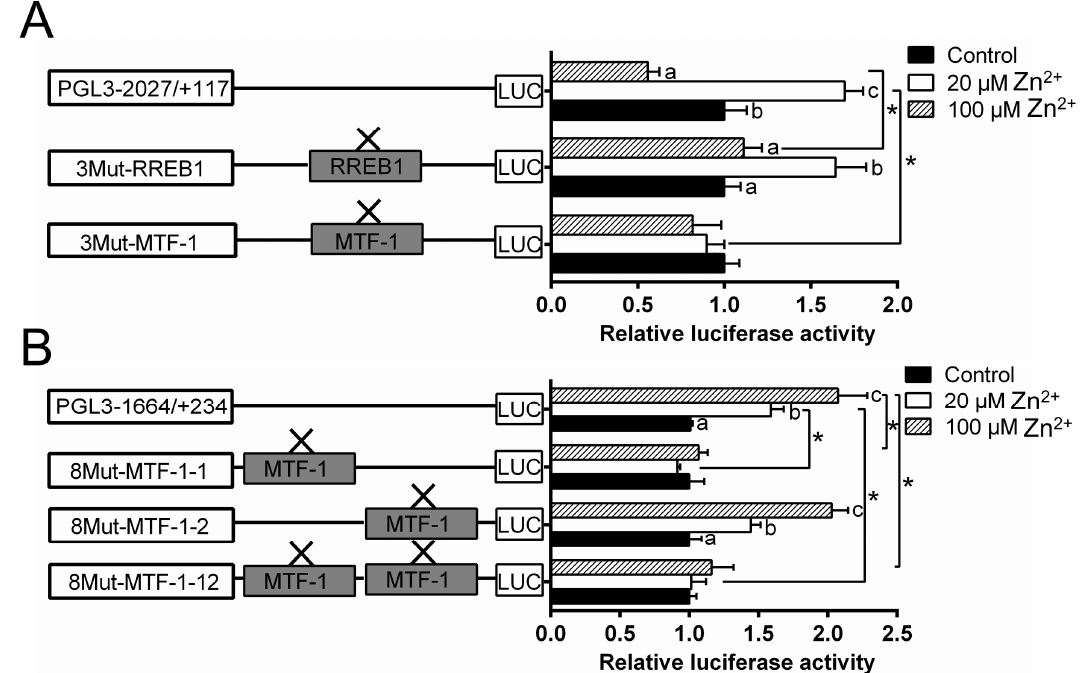
Figure 4. Assays of predicted MTF-1 and RREB1 binding sites of yellow catfish ZIP3 and ZIP8 promoters after site-directed mutagenesis. ( A ) Site mutagenesis of MTF-1 on pGl3- ZIP3 -2027 vector and RREB1 on pGl3- ZIP3 -2027 vector; ( B ) site mutagenesis of MTF-1 on pGl3- ZIP8 -1664 vector. Values mean the ratio of activities of Firefly to Renilla luciferase, normalized to the control. Results were presented as mean ± SEM ( n = 3). Asterisk (*) indicates significant differences between different 5 ′ unidirectional deletion plasmids under the same treatment ( p < 0.05). Different letters (a, b and c) indicate significant differences between different treatments in the same plasmid ( p < 0.05).